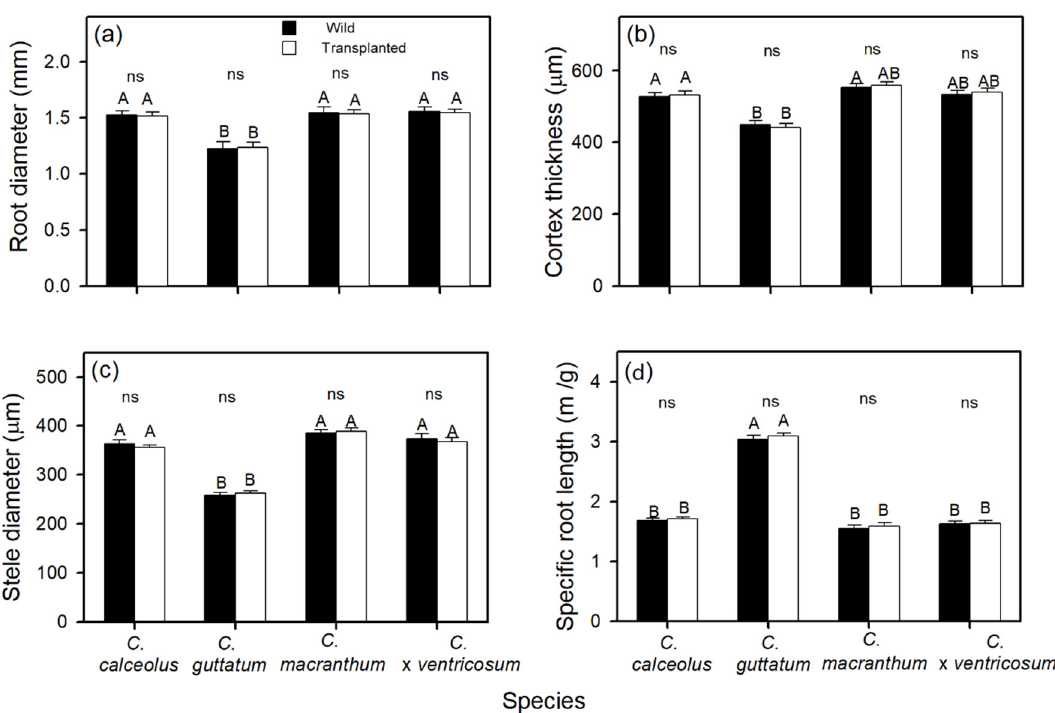
Figure 3. Root diameter ( a ), cortex thickness ( b ), stele diameter ( c ) and specific root length ( d ) in four wild and transplanted Cypripedium species. The error bars represent 1SEM. ns indicates the difference between wild and nursery at insignificant levels. Different capital letters within one habitat represent a significant difference among different species according to Fisher’s